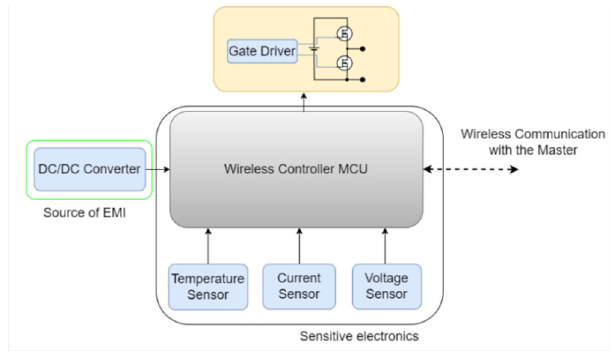
Figure 4. Hardware components in a Smart Battery cell.